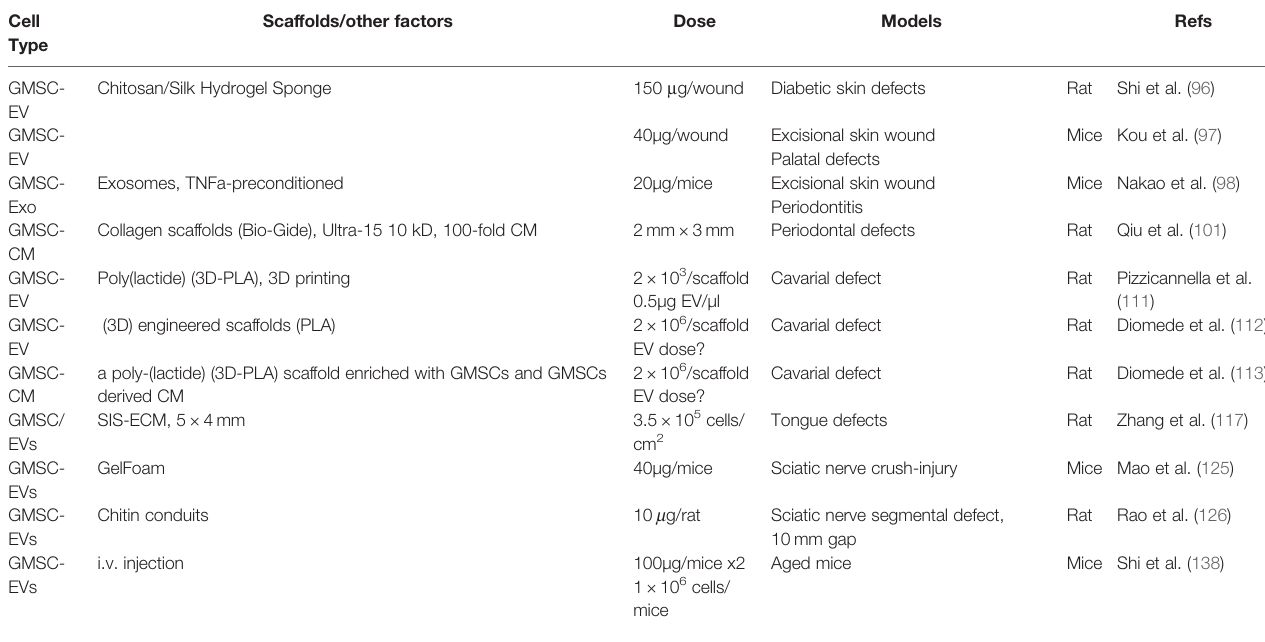
TABLE 7 | Potential application of GMSC-EVs and conditioned medium in regenerative